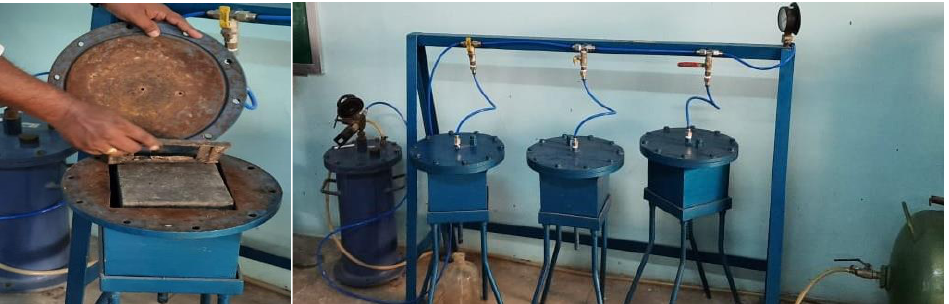
Figure 3. Water permeability apparatus and setup.